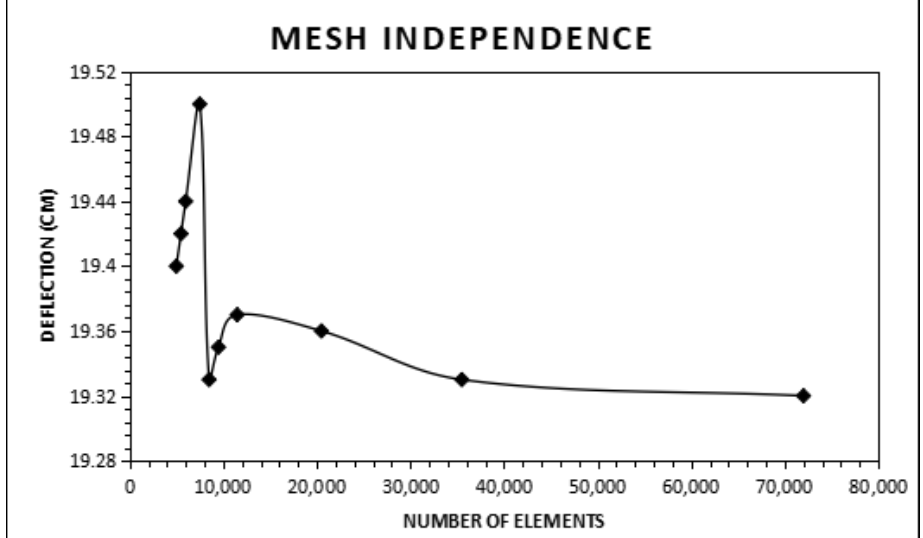
Figure 15. Mesh convergence study for landing gear strut